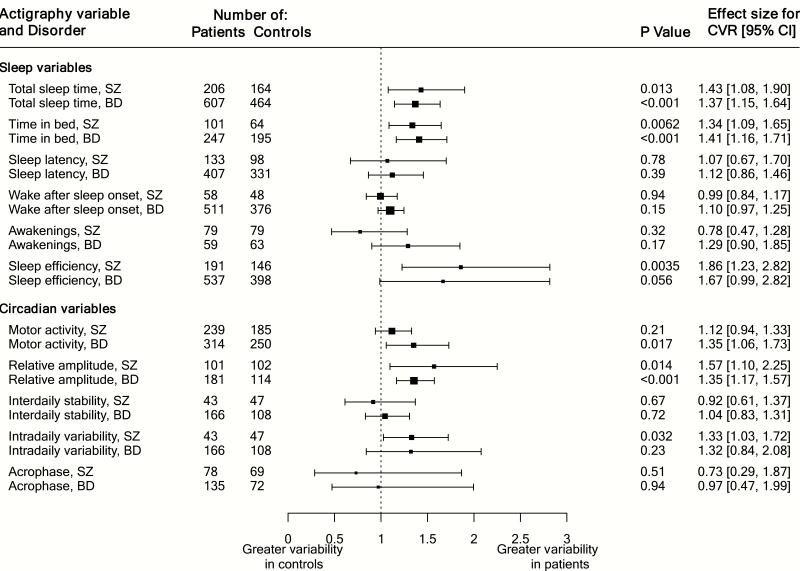
Summary of mean-scaled coefficient of variation ratio for all variables, log-transformed scale.